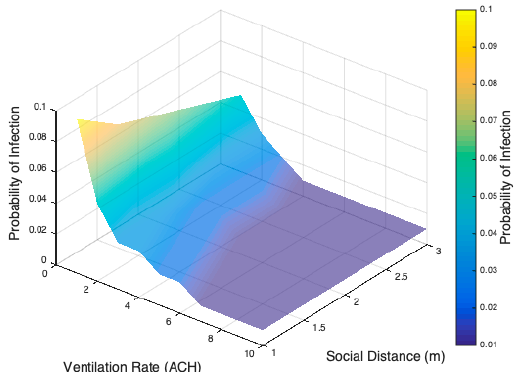
Figure 9. Impacts of MV ventilation rate and social distance on POI for July 22 nd .